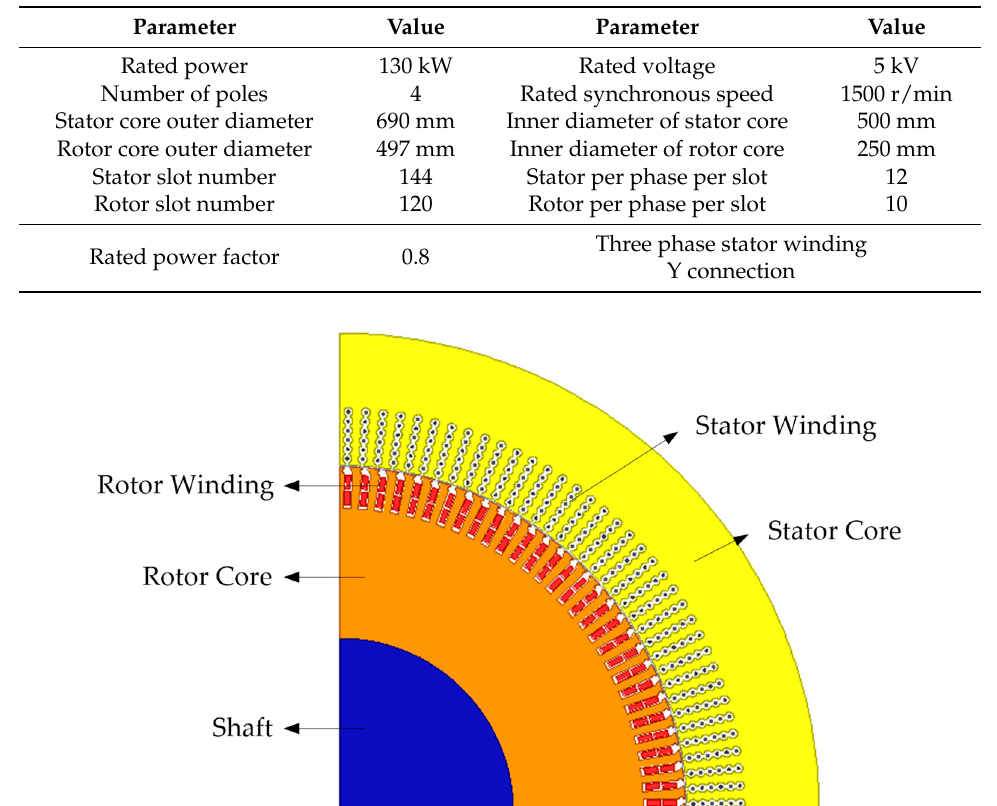
Table 1. Basic generator parameters of the asynchronized high-voltage generator.